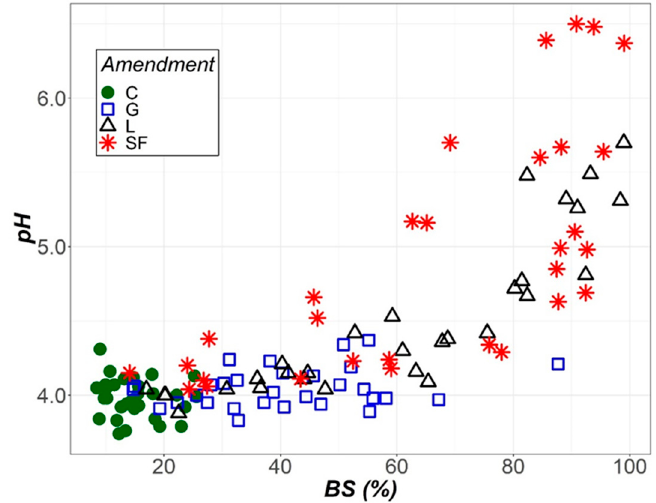
Figure 9. Soil pH and base saturation (BS) as a function of the liming treatment (Control (C), gypsum (G), limestone (L) and sugar foam (SF)).